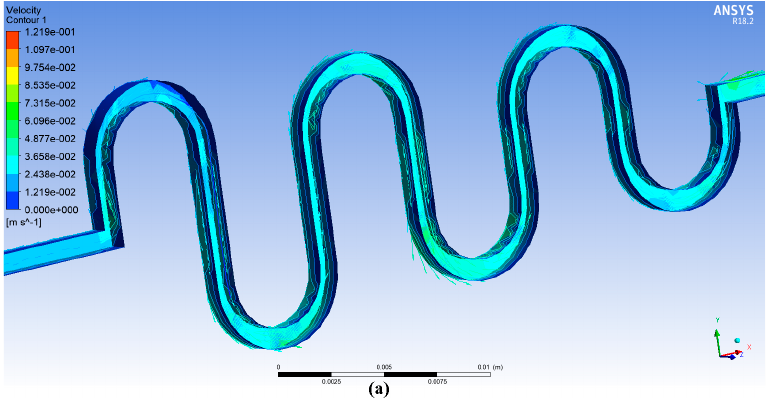
Table 2. Simulated results with Mamdani’s